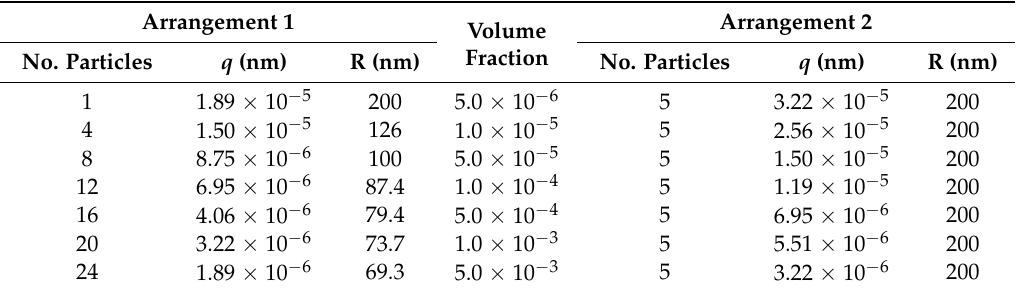
Table 1. Number of particles and their radii along with sample space side ( q ) in the first three columns. Similar data is shown for fixed particle size arrangement in the last three columns. The center column contains the volume fraction values common to both